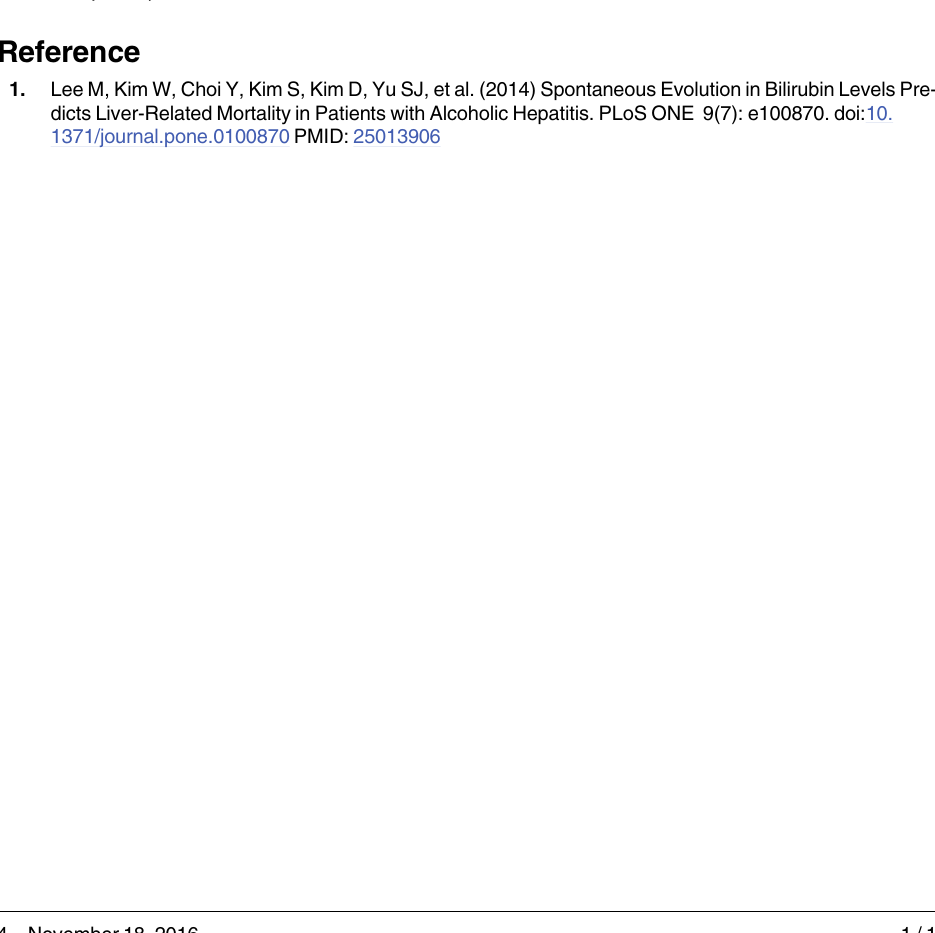
Table 3. Equation for